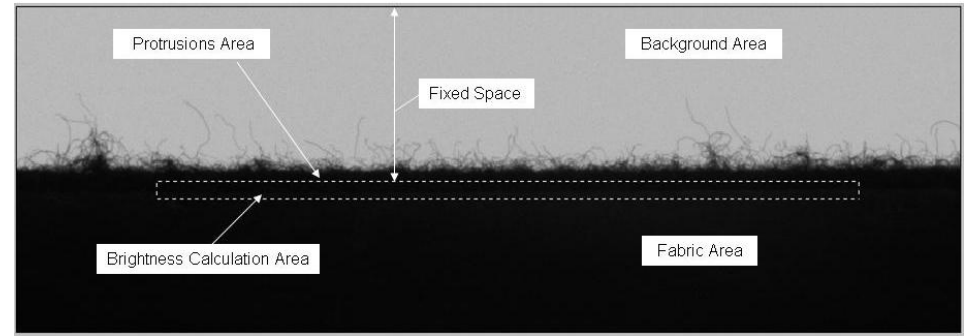
Figure 1. An example of the image dataset.